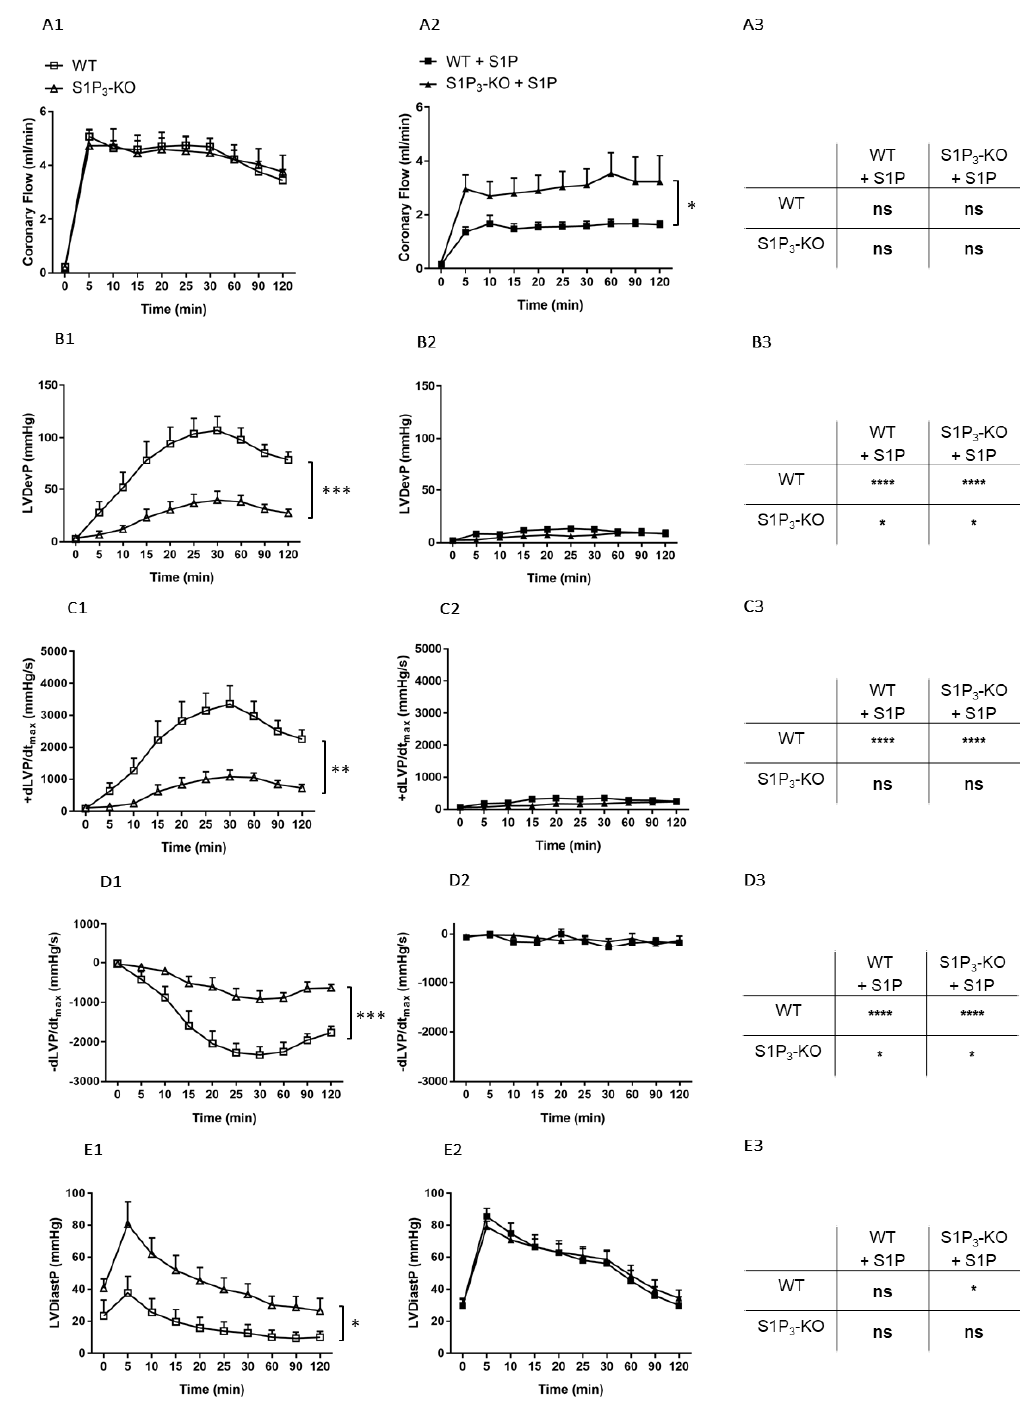
Figure 5. Postischemic coronary flow (CF) ( A ), left ventricular developed pressure (LVDevP) ( B ), +dLVP/dt max ( C ), − dLVP/dt max ( D ) and left ventricular diastolic pressure (LVDiastP) ( E ) in isolated WT and S1P 3 knock-out (KO) mouse hearts without (left panels: A1 – E1 ) or with S1P administration (middle panels: A2 – E2 ) for 5 min to the perfusate at 10 − 6 M before the induction of a 20-min ischemia followed by a 120-min reperfusion period. The right panels ( A3 – E3 ) demonstrate statistical comparison of the parameters captured at the end of the reperfusion period. Mean ± SEM; n = 6, 8, 7, 7; * p < 0.05, ** p < 0.01, *** p < 0.001, **** p < 0.0001, with two-way repeated measurement ANOVA and